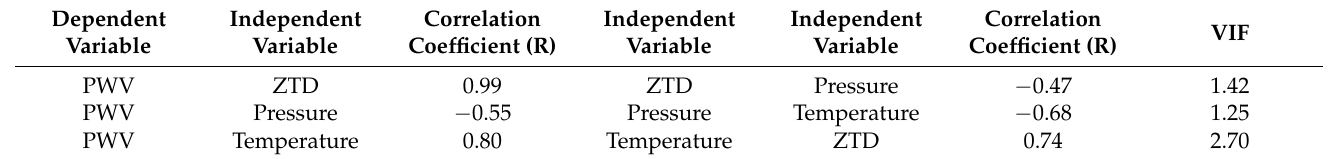
Table 3. The correlation of dependent and independent variables and their